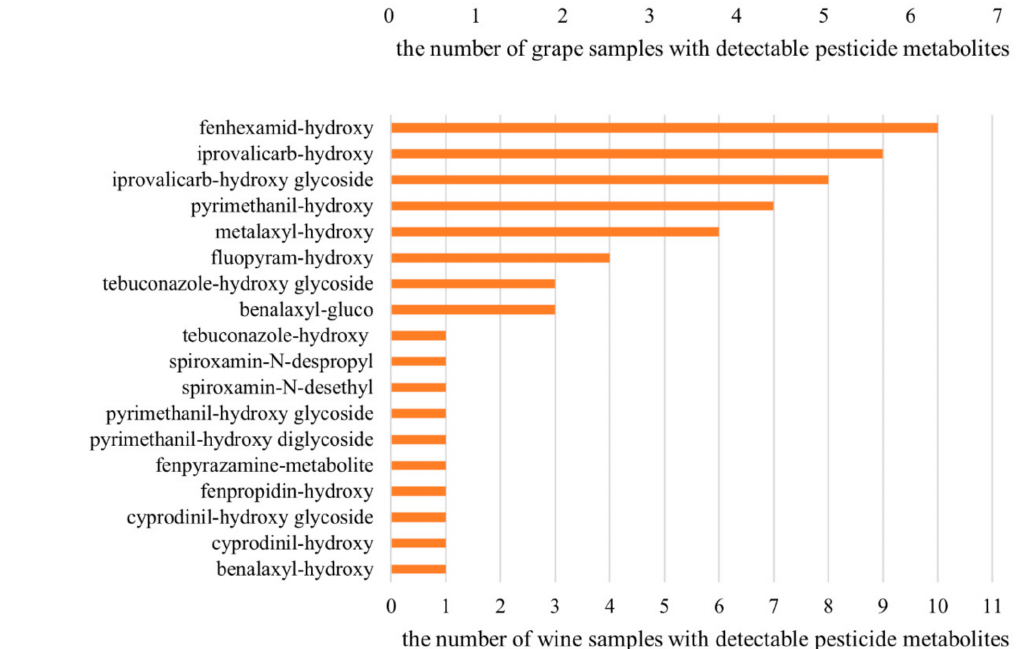
Figure 2. The numbers of grape (total n = 10) and wine (total n = 12) samples from conventional production with detectable pesticide